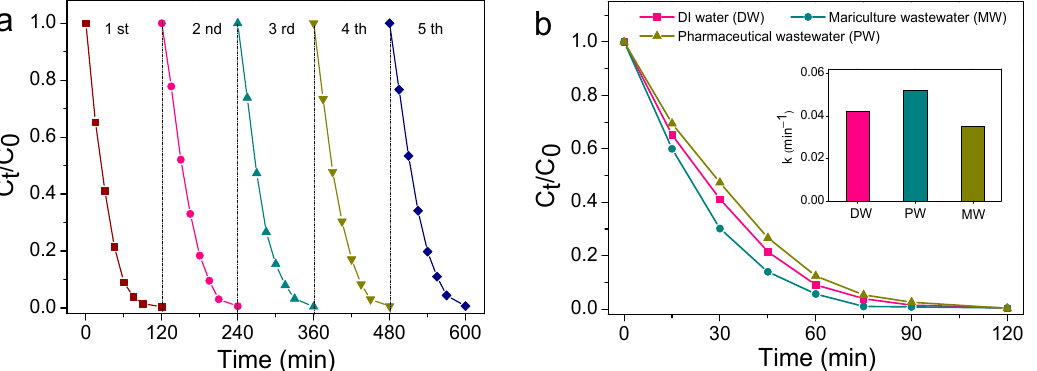
Figure 8. Five consecutive cycling tests using TiO 2 NNs-Co 3 O 4 PEC system ( a ). PEC degradation of SMT in actual pharmaceutical wastewater and mariculture wastewater of TiO 2 NNs-Co 3 O 4 system ( b ).